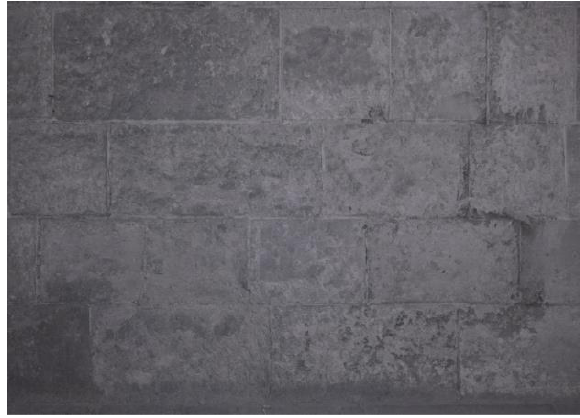
Figure 8. IR image of trial area 1 at Sint Baafs Cathedral in